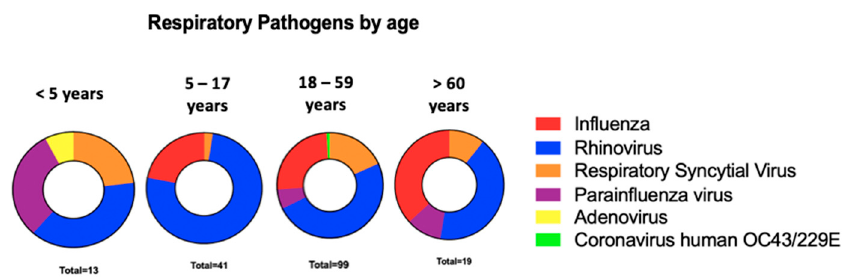
Figure 2. Pathogens founded with the respiratory panel according to age. This scheme shows the frequency according to age group of the main respiratory microorganisms detected with the respiratory panel that cause ARI in patients with negative RT-PCR result for SARS-CoV-2. When we compared the demographic and clinical characteristics according to those syncytial virus), the variables that showed statistical relevance were age, days of symp-